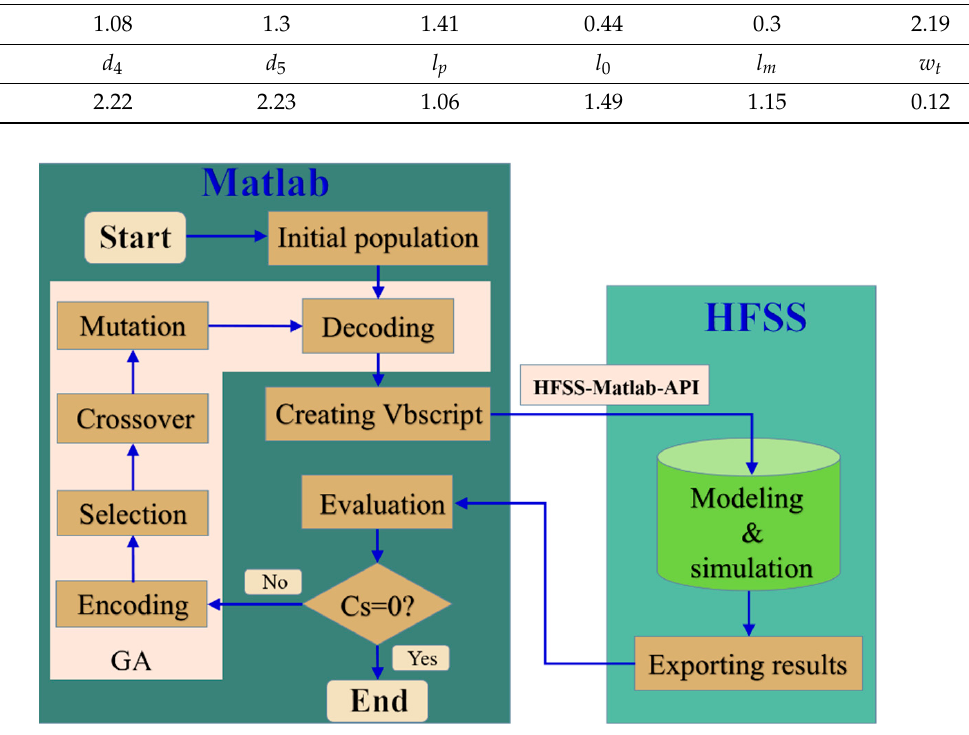
Figure 2. The framework of HFSS-MATLAB joint optimizing platform. Table 1. The dimensions of the optimized series-fed patch antenna array. (Unit: mm).